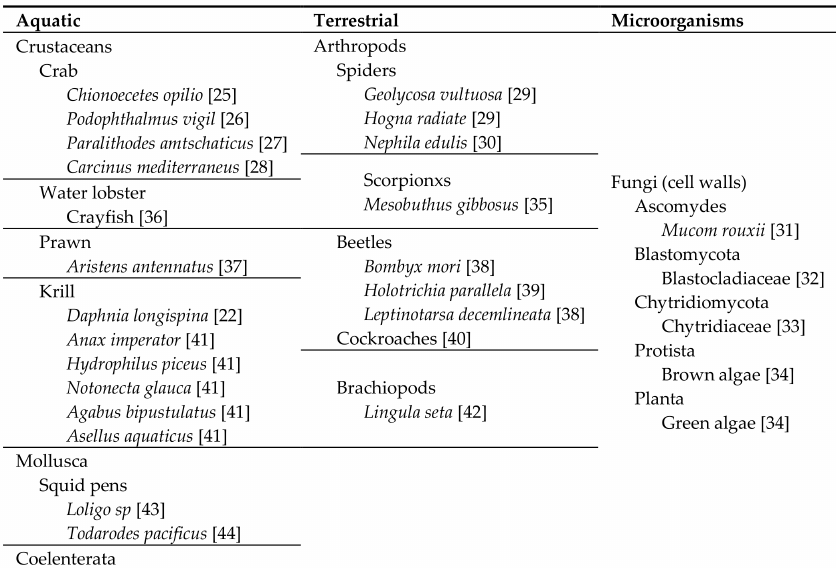
Table 1. Sources of chitin and chitosan from various aquatic and terrestrial